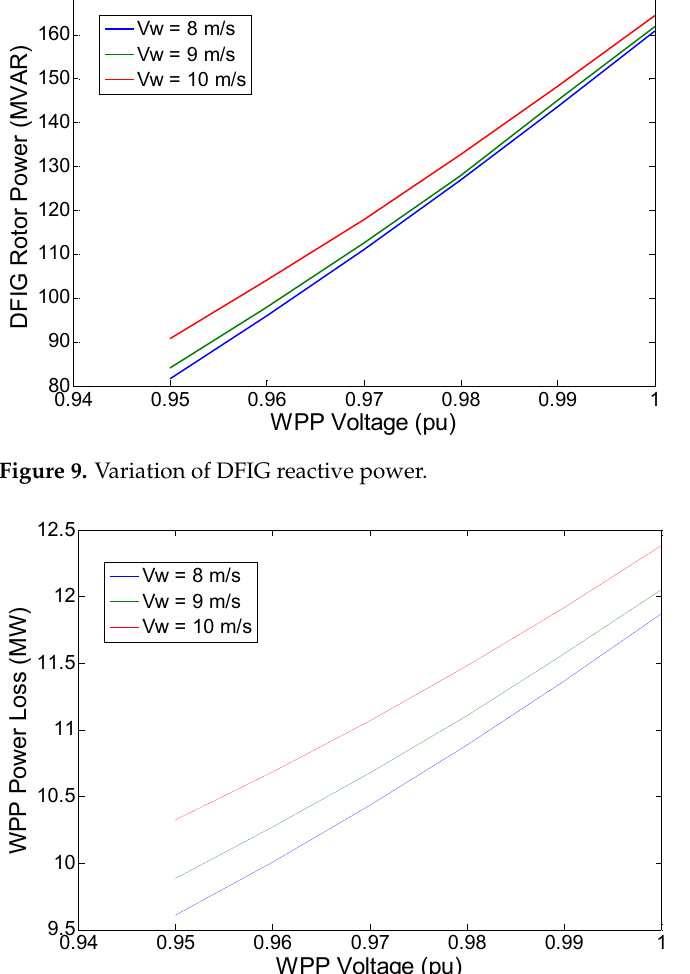
Figure 10. Variation of WPP active power loss.